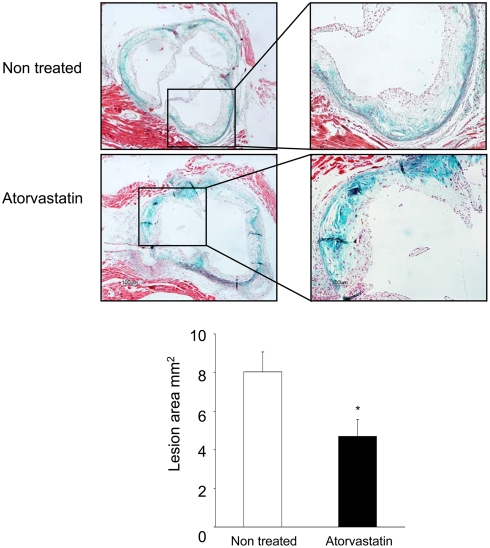
Atorvastatin treatment retards atherosclerosis development.Aortic root samples were stained using Masson tricrome. Lesion areas were measured from the intima to the lumen. Areas were determined using Image Pro-Plus software. Figure shows representative photographs from each group of 8 animals at magnifications of 40× and 100×. Lower panel shows mean±SD of lesion areas in mm2. *p<0.05 vs. control.